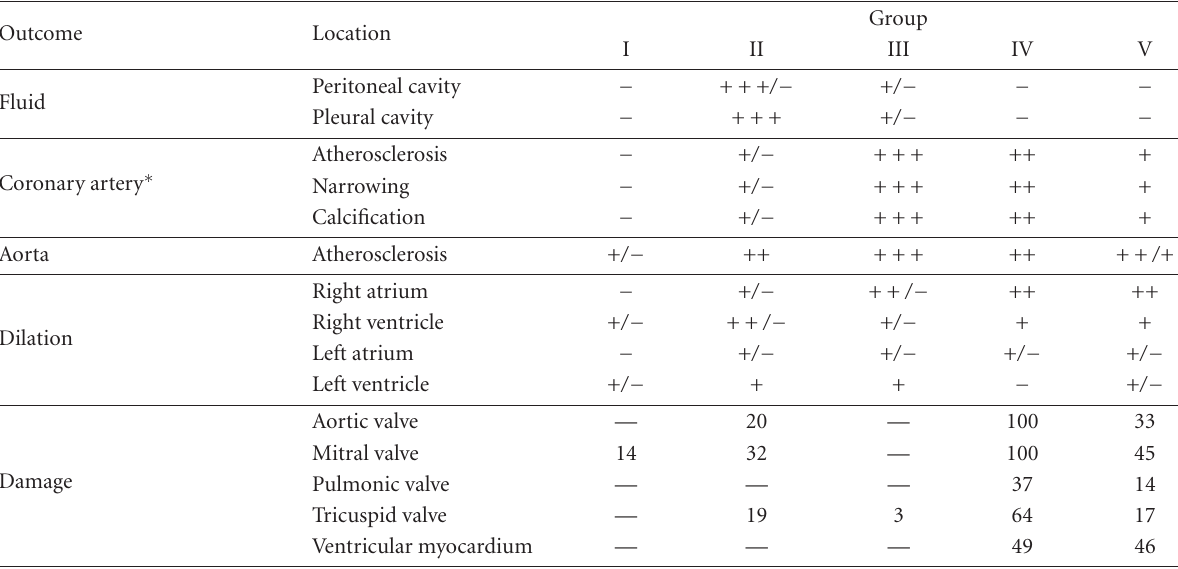
Table 5. Cardiovascular damage for each group. The model-based groups are defined by the probabilities response for the variables sometimes represented on a semiquantitative scale: “+ + +” denotes severe, while “++,” “+,” and “ − ” denote moderate, mild, and the absence of lesions; “+ + / − ” denotes mixture of moderate and absent; “+ / − ” denotes mixture of mild and absent; “+ + / +” denotes a mixture of moderate and mild; “+ + + / − ” denotes a mixture of severe and absent. ∗ means the average of right coronary artery, left main coronary artery, circumflex branch, and anterior descending